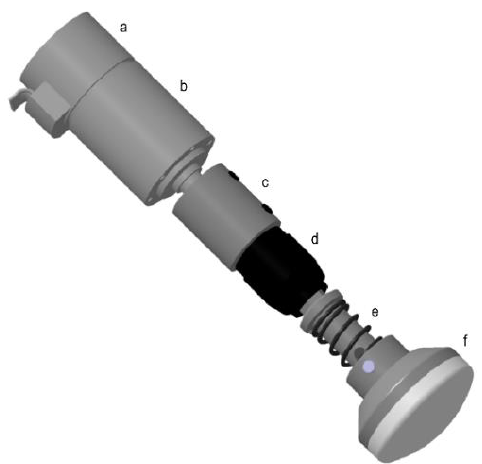
Figure 10. Internal components for the fixed-axis rotation design: (a) motor, (b) gear, (c) coupling joint, (d) quick release coupling, (e) spring, (f) 30 mm diameter backing pad.